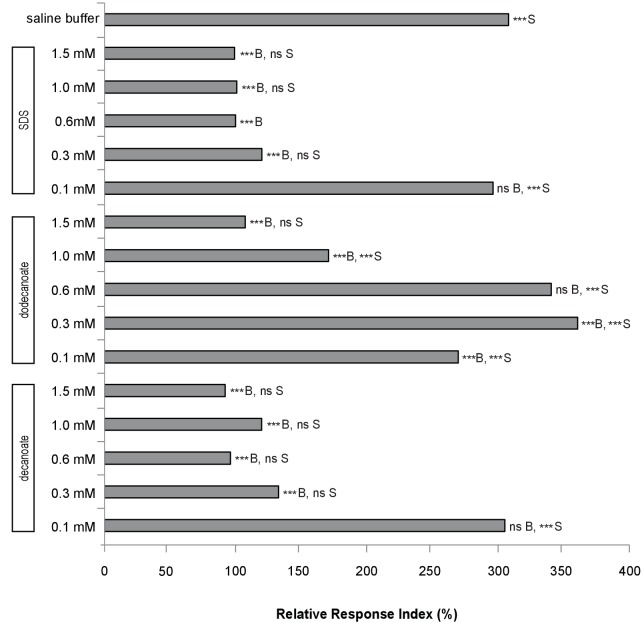
Response to different concentrations of SDS, dodecanoate and decanoate.The response to SDS, dodecanoate and decanoate at the tail is shown. Note that compounds are represented as the predominant form in a pH 7 solution, the carboxylates. One-way ANOVA and Tukey’s post-hoc test were performed. For all experimental samples, n ≥ 40 for the experimental group, n ≥ 40 for the 0.6% SDS positive control, and n ≥ 40 for the saline buffer negative control. ***B, p<0.001; ns B,not significant compared with a control buffer; ***S, p<0.001; ns S, not significant compared with SDS positive control. Exact values and additional pairwise comparisons are included in Figure 2—source data 1 and Figure 2—source data 2.